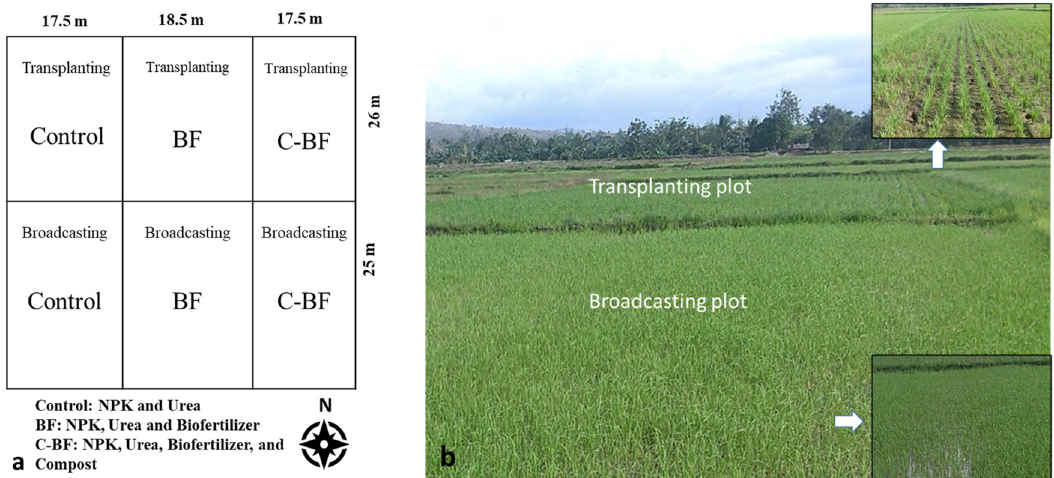
Figure 2: Treatment placement in the fi eld experiment in transplanting and broadcasting plots ( a ) and 21 - day - old rice in transplanting and broadcasting plots ( b )